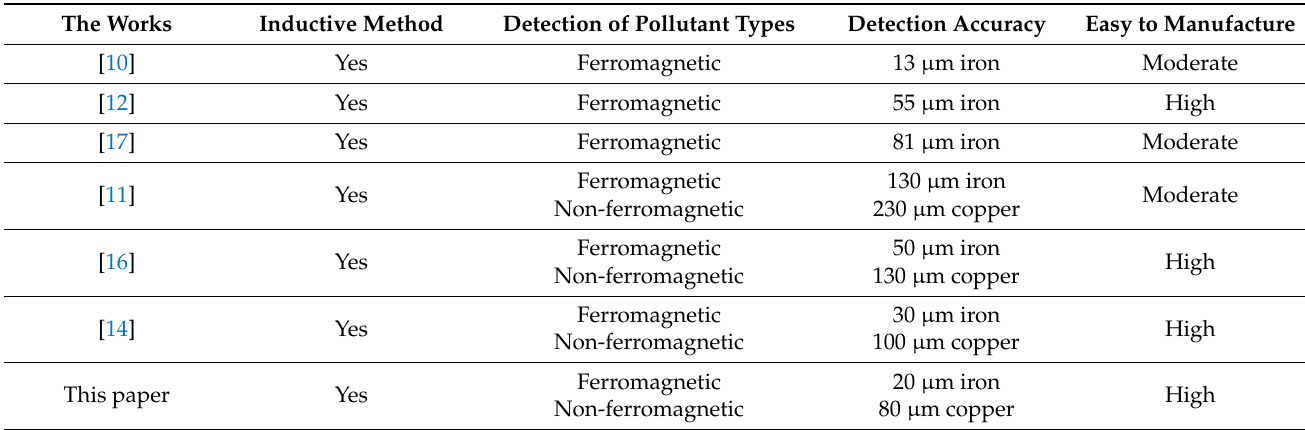
Table 2. Comparison of other